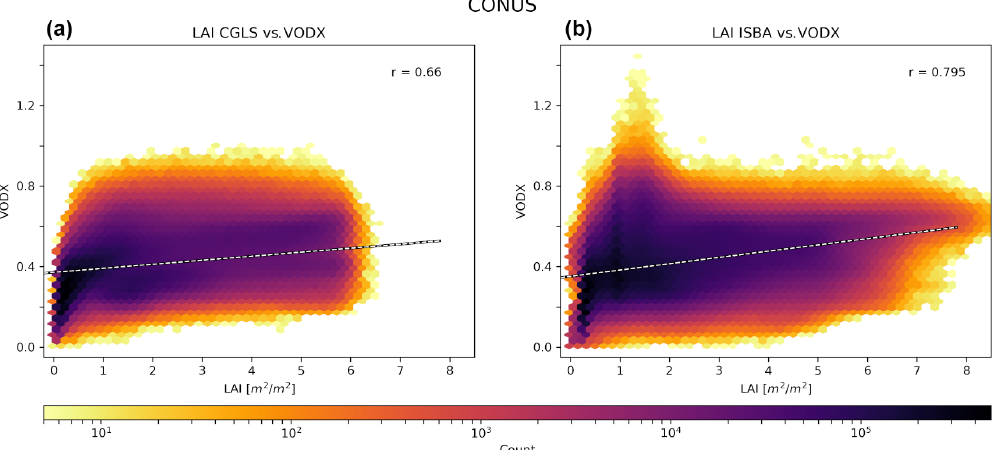
Figure 4. Density scatterplots detailing the relationship between LAI and VODX from VODCA. This comparison only analyzes where and when there are both LAI and VOD observations. Warm colors represent more counts of points in the hexagonal bins. The color bar is logarithmically scaled in order to emphasize the distributions, and bins with under five counts are eliminated. A regression line and correlation score are added. This comparison only looks at points during the growing-season months (April–September) from 2003 to 2018. Panel (a) compares VODX to LAI from CGLS observations, while panel (b) compares VODX to LAI from the ISBA